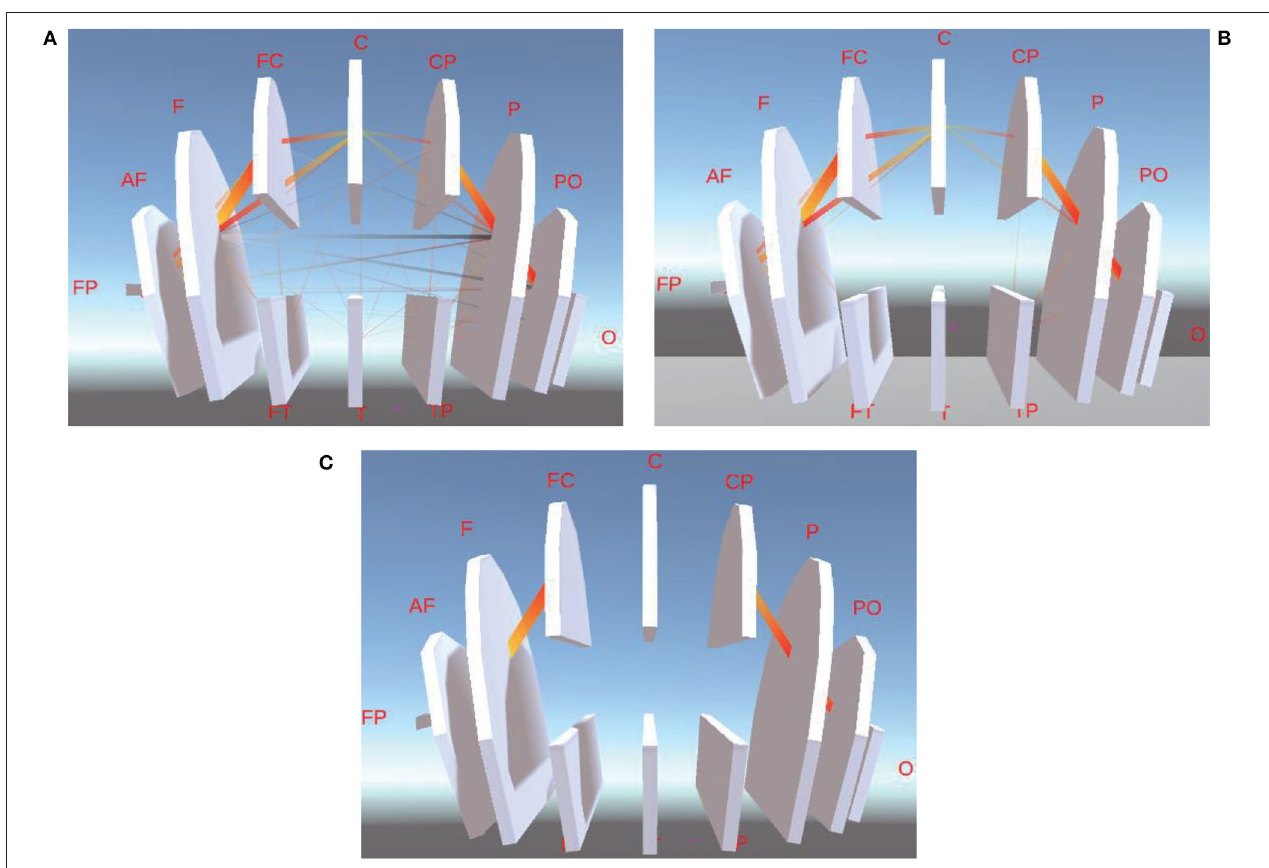
FIGURE 7 | This is between-BR FC visualization of different ranges of PCC. (A) is between-BR FC visualization of the whole PCC. (B,C) are between-BR FC visualization of 1/2 and 1/8 of PCC.